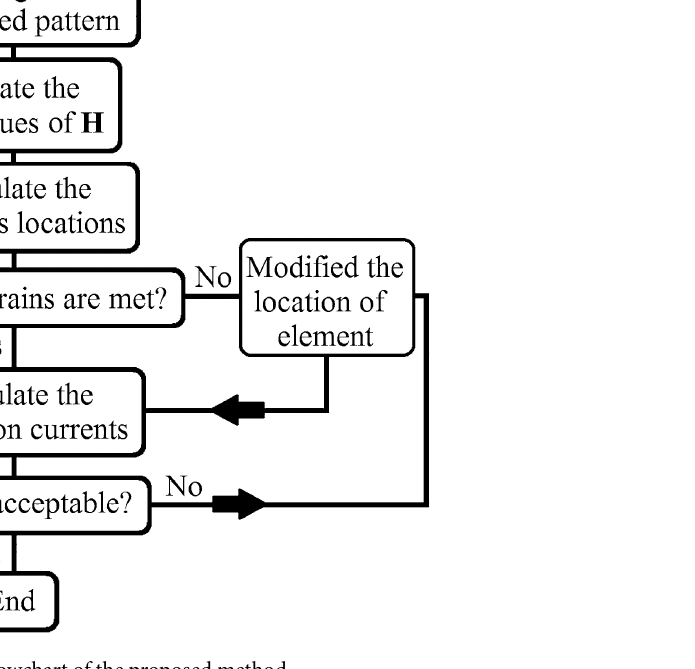
Figure 1. The flowchart of the proposed